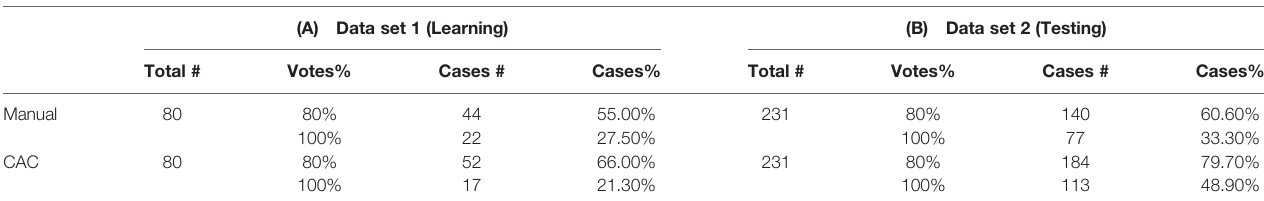
TABLE 3 | Agreement of RECIST 1.1